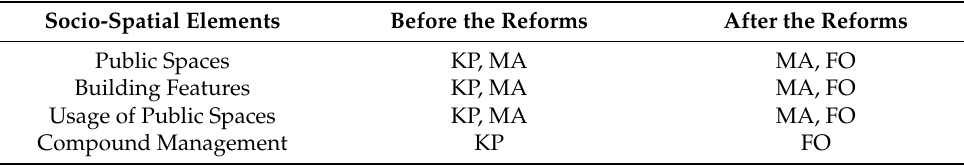
Table 2. Data collection methods for different research aspects. Socio-Spatial Elements Before the Reforms After the Reforms Public Spaces KP, MA MA, FO Building Features KP, MA MA, FO Usage of Public Spaces KP, MA MA, FO Compound Management KP